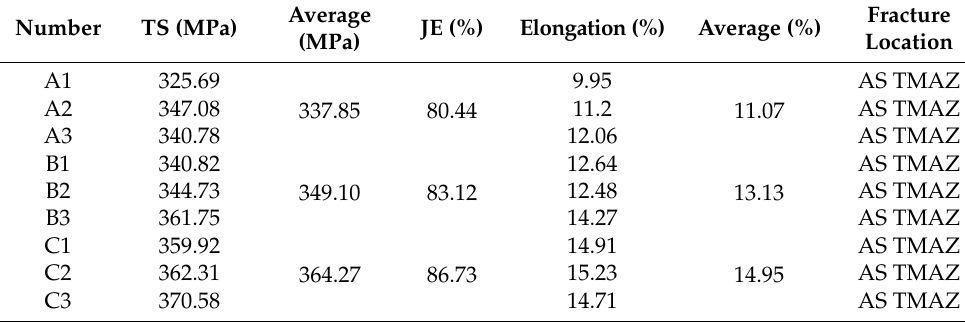
Table 4. Results of tensile test of joints welded by different tool pin